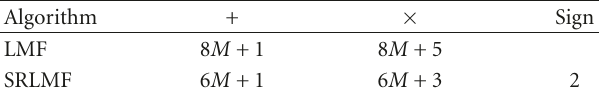
Table 2: Computational load per iteration for LMF and SRLMF algorithms when data is complex.